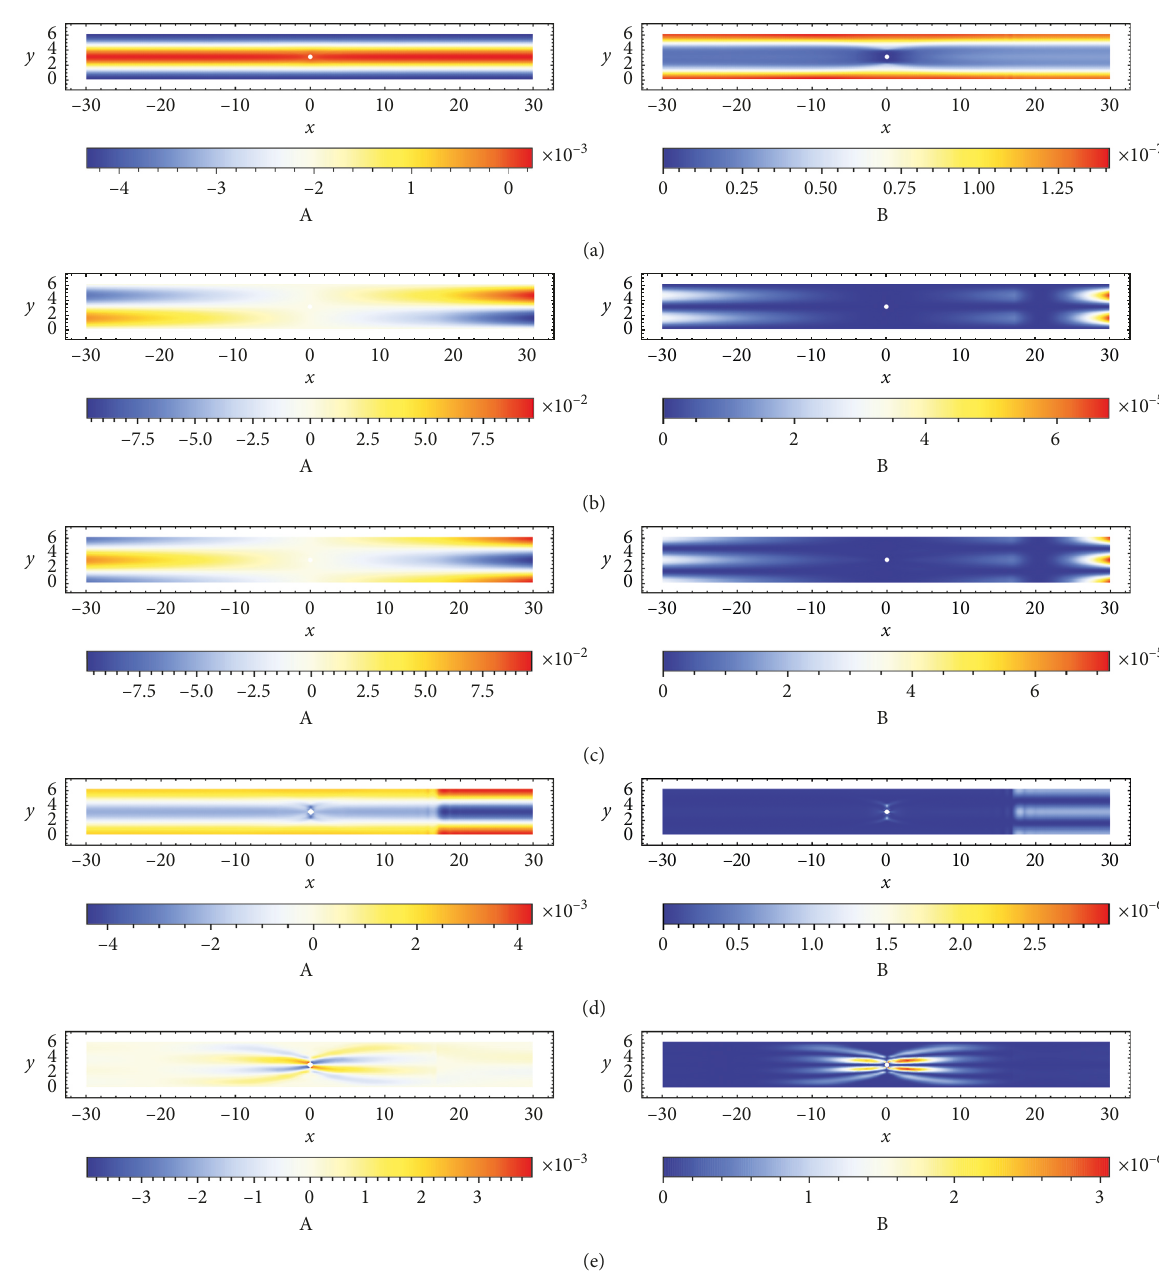
Figure 6: Long cylinder with junctions: expected value and variance of the first eigenmode. Solution computed with p � 3 and L � 2 (45 collocation points). (a) Expected value (A) and variance (B) of the component μ . (b) Expected value (A) and variance (B) of the component v . (c) Expected value (A) and variance (B) of the component w . (d) Expected value (A) and variance (B) of the component θ . (e) Expected value (A) and variance (B) of the component ψ